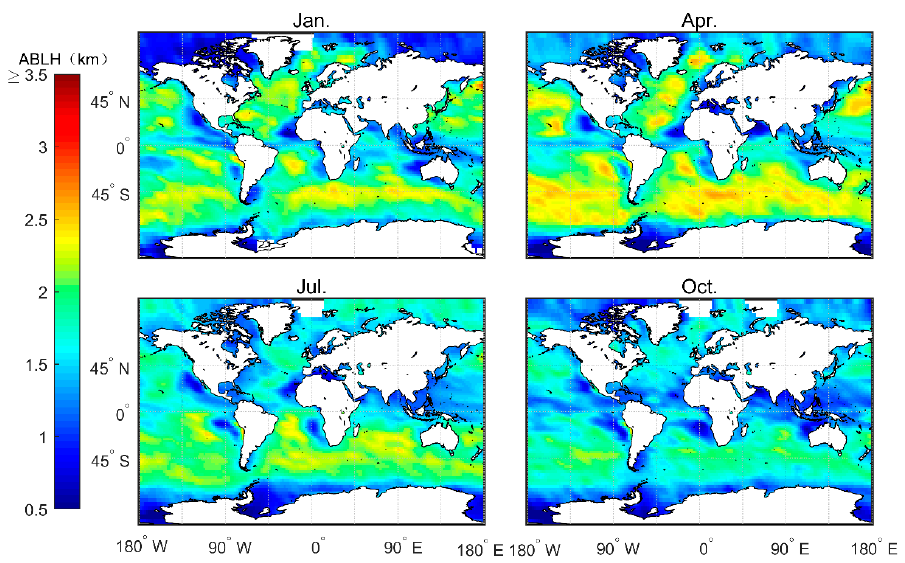
Figure 7. The perennial average monthly wind-driven current represented by the monthly mean sea surface temperature field and wind field.